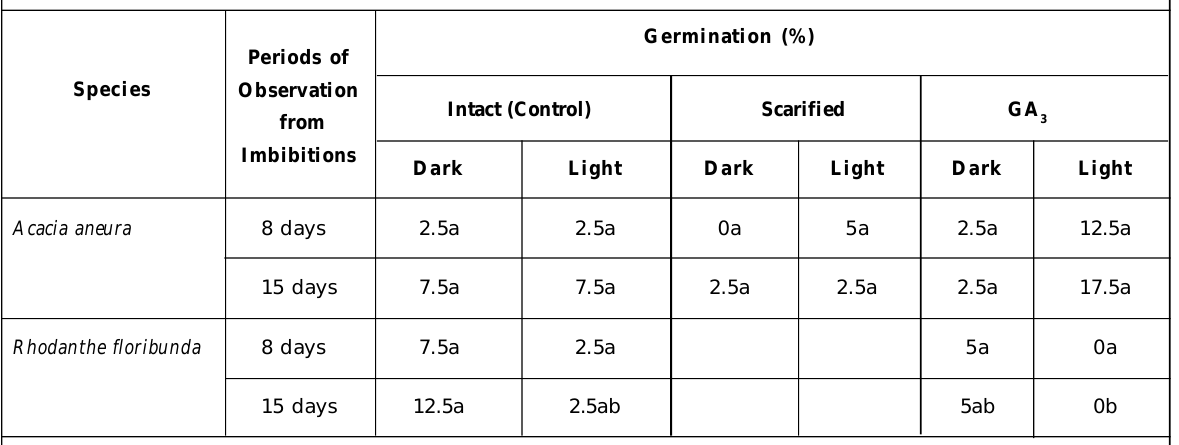
Periods of Observation from